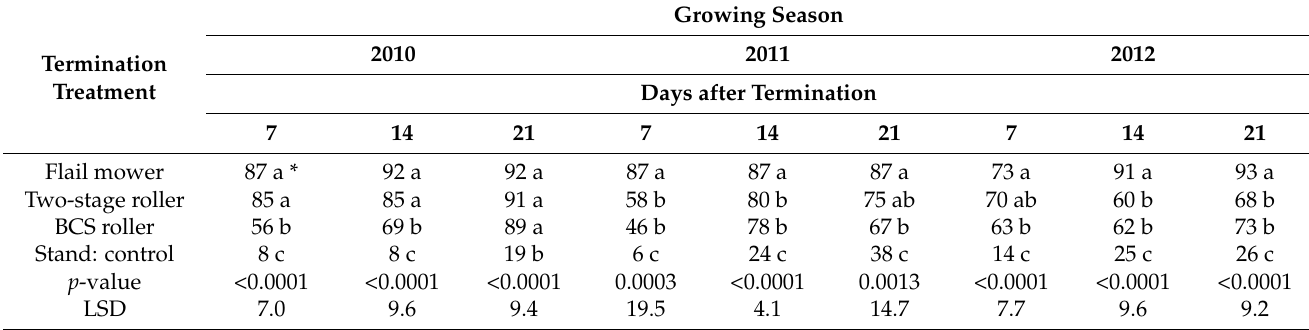
Table 8. Termination rates (%) for hairy vetch during three weeks of evaluation in three growing seasons